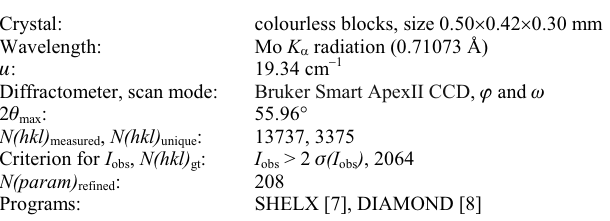
Table 1. Data collection and handling.